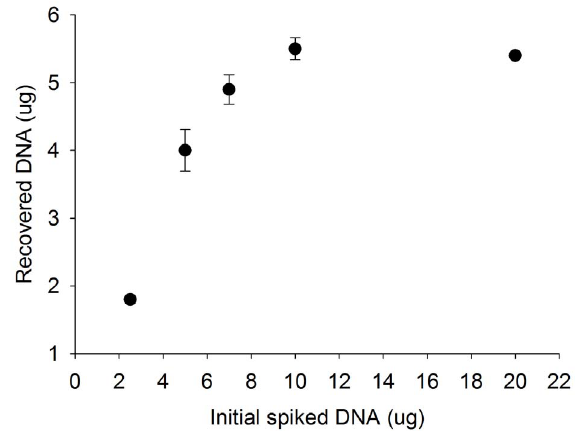
Figure 10. As the mass of spiked DNA is increased the mass of DNA recovered using the magnetic bead-based method increases and then plateaus at 5.5 m g (mean 6 s.d., n=3).